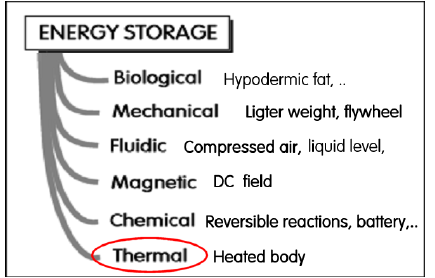
Fig. 1. Among energy storage methods, the thermal storage handles lower quality energy, not directly convertible into other forms – particularly not into the most often demanded electric energy. It is thus particularly useful for simple applications such as keeping a more or less constant temperature of living bodies (humans) and objects with which humans come in